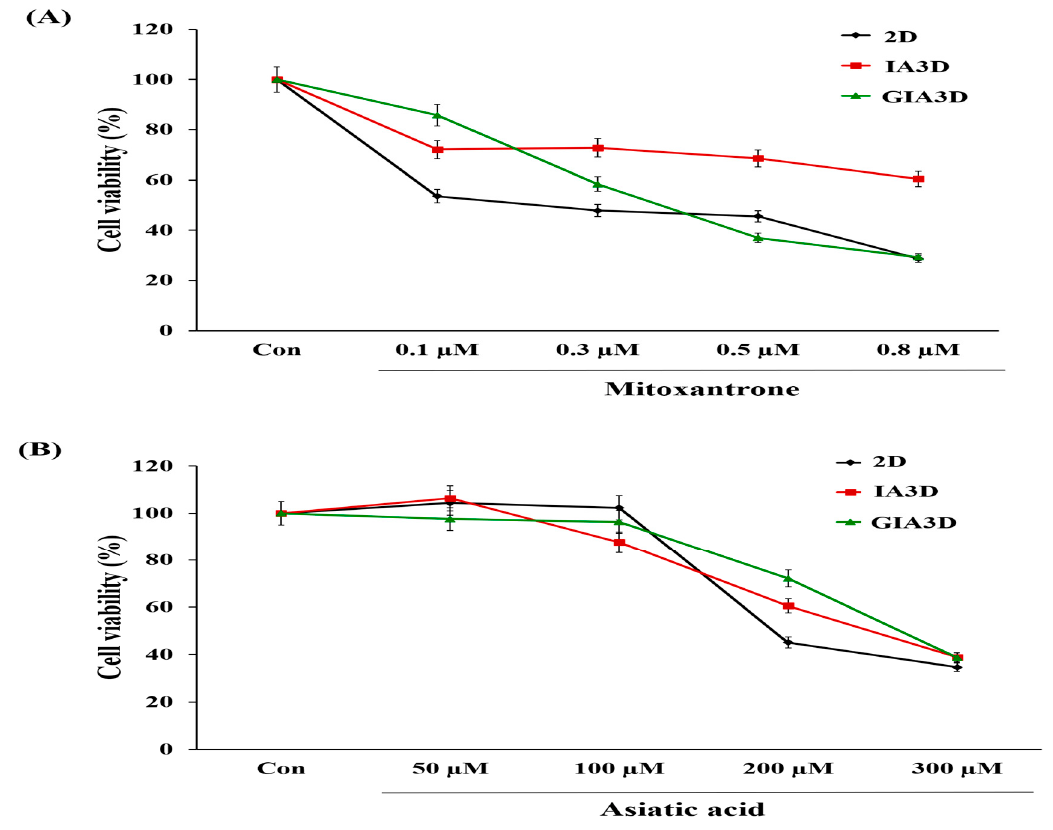
Figure 10. Cytotoxic effects of drugs on HaCaT cells. ( A,B ) Effects of mitoxantrone and asiatic acid drugs on HaCaT cells cultured in two-dimensional culture, industrial acrylonitrile butadiene styrene, and gold nanoparticle-coated ABS scaffold. The cells were seeded at 5 × 10 4 cell/mL, incubated for 72 h afterward, treated with mitoxantrone (0.1–0.8 µM), or asiatic acid (50–300 µM) for 24 h. The relative cell viabilities were calculated as the percentage of untreated cells. Results are expressed as mean ± SD, n = 3.